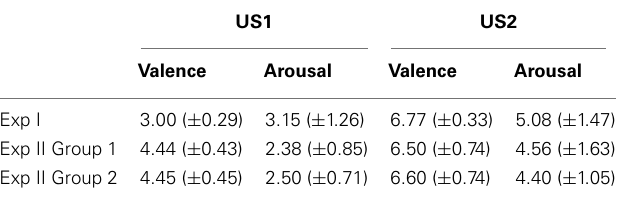
Table 3 | Mean ratings of valence and arousal for US1 and US2 with the SAM. US1 US2 Valence Arousal Valence Arousal Exp I 3.00 ( ± 0.29) 3.15 ( ± 1.26) 6.77 ( ± 0.33) 5.08 ( ±